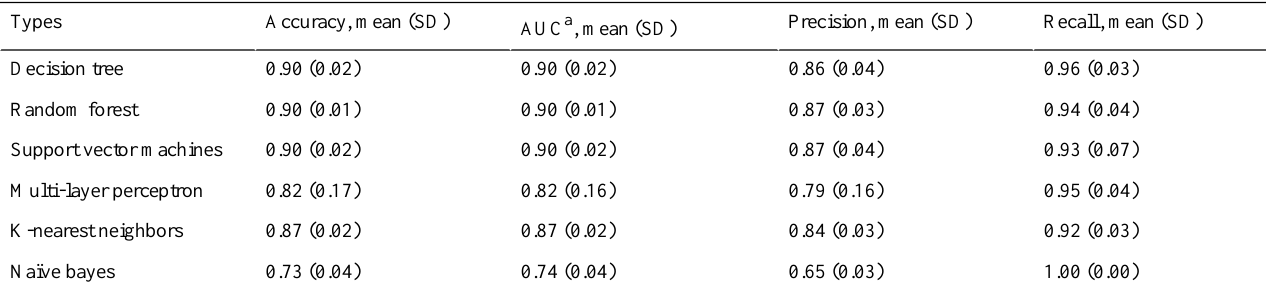
Table 6. Mean performance metrics and respective SDs (in years) for the classification of minor versus adults for the male subjects.